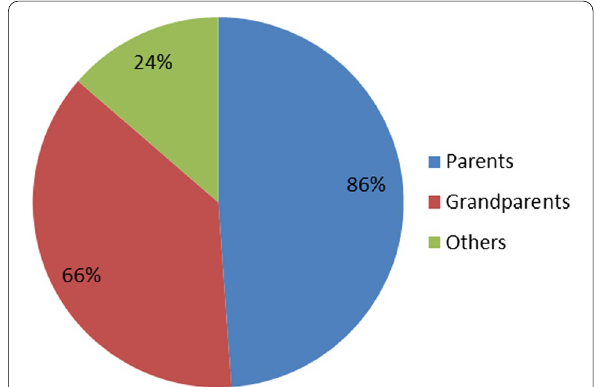
Fig. 4 Sources of medicinal plant knowledge for management of TB remedy in Kitgum and Pader districts,